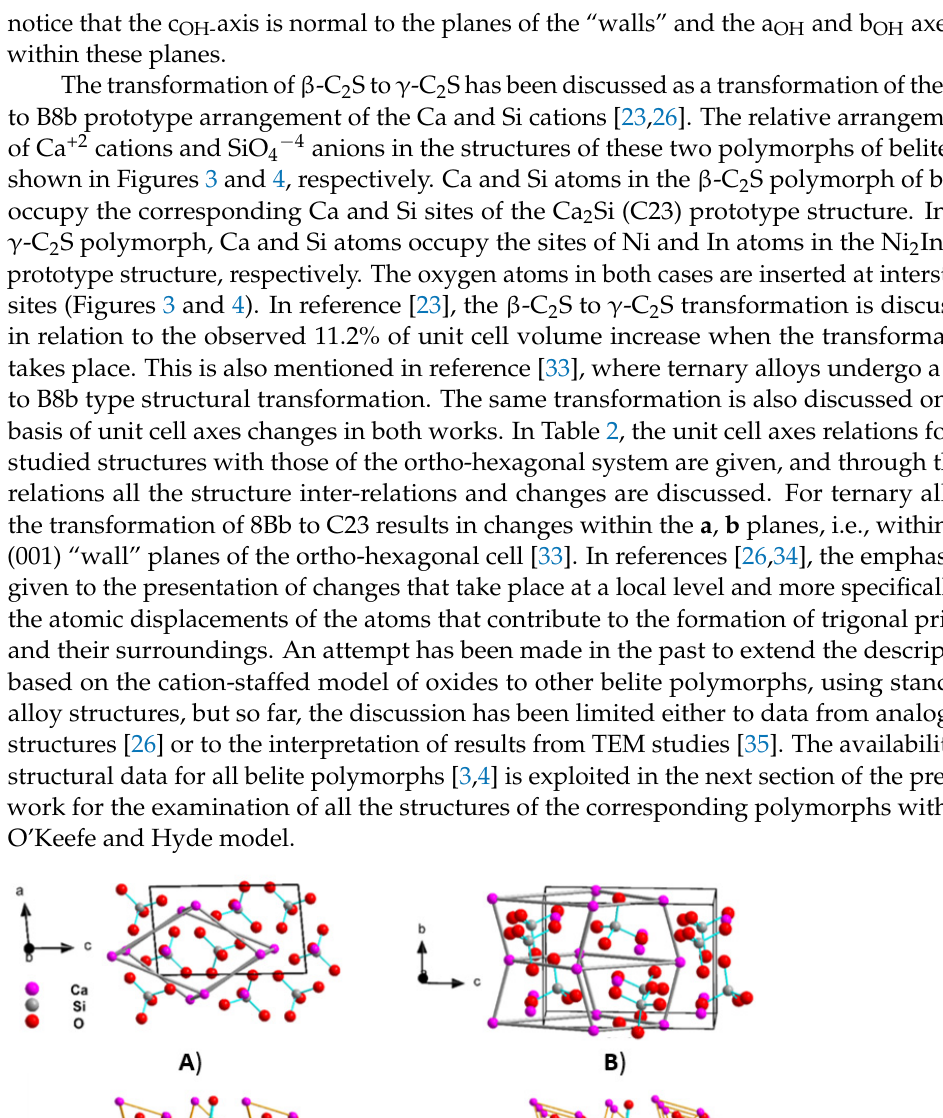
Table 2. Unit cell relation of the C23 prototype structure and the unit cells of the five polymorphs of belite with the basic hexagonal unit cell of the 8B2 structure.